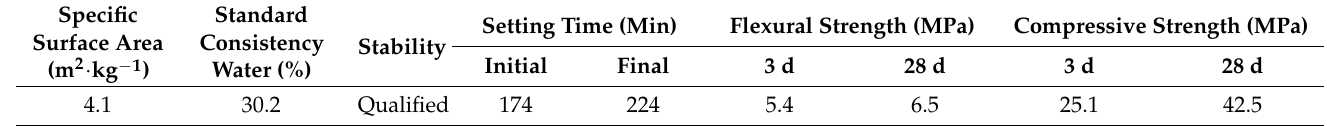
Table 1. Physical and mechanical properties of cement.